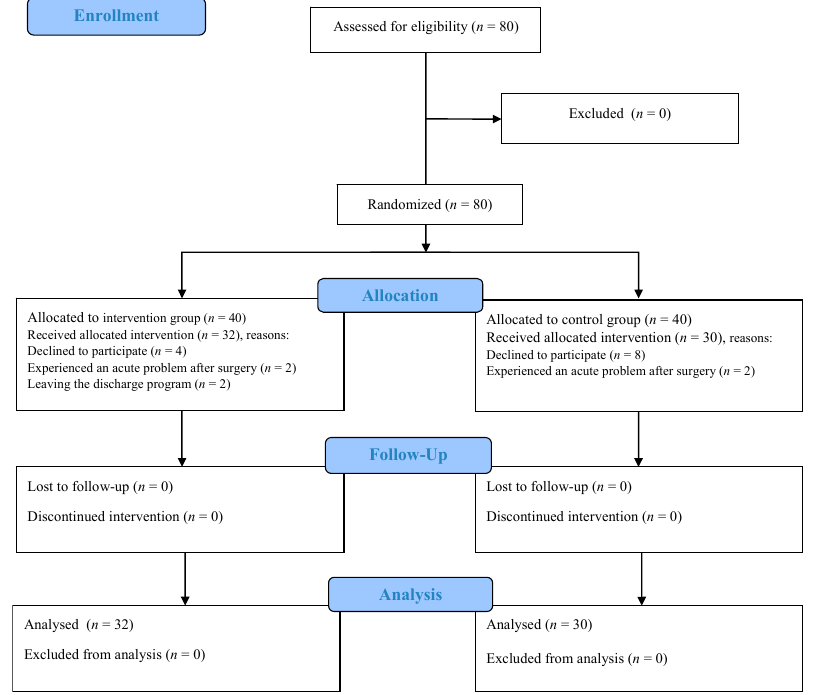
Figure 1. The study process according to the CONSORT flow